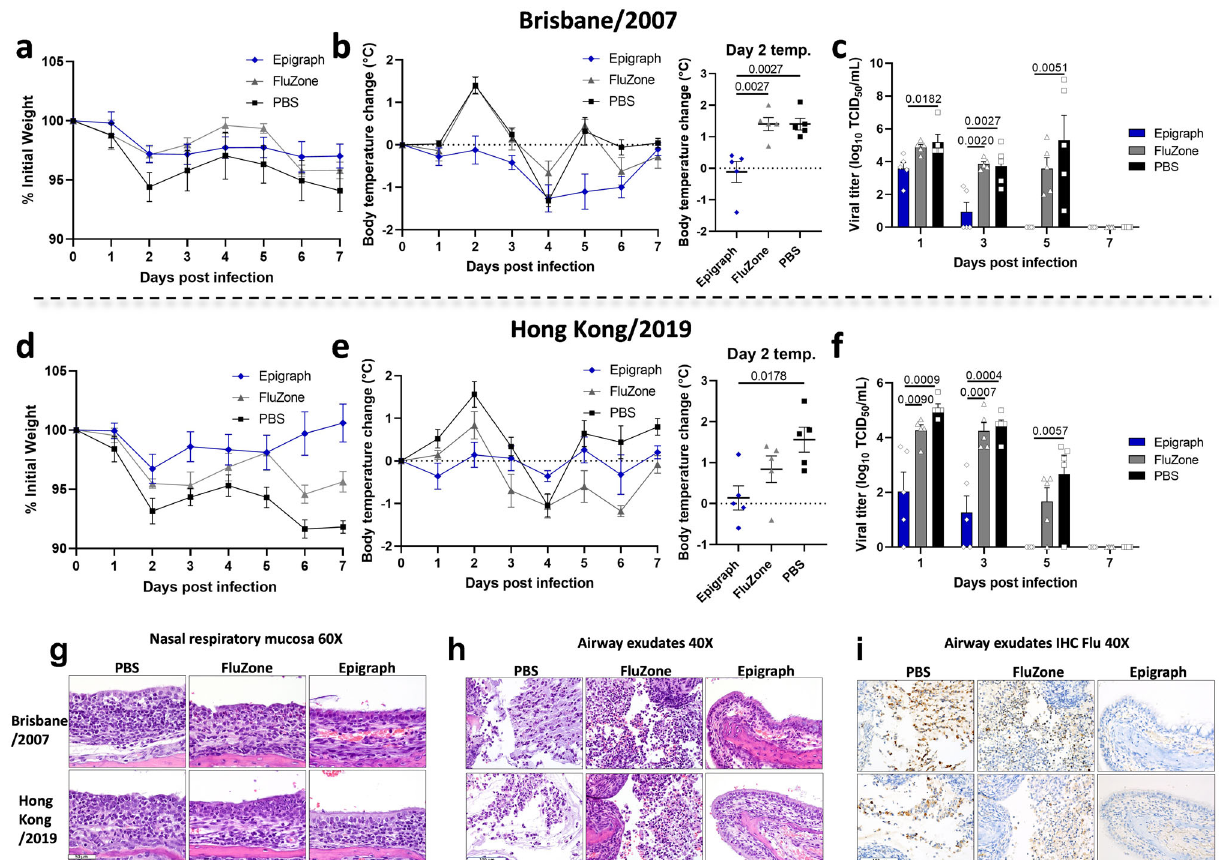
Fig. 8 Epigraph immunization protects ferrets against challenge with two contemporary H3 viruses. Ferrets were immunized twice with 5 × 10 10 vp of HAdV-5-Epigraph, the FluZone vaccine, or a mock PBS vaccine. Two weeks after boosting, ferrets ( n = 5) were challenged intranasally with 10 5 TCID 50 of contemporary strains Brisbane/2007 ( a – c ) or Hong Kong/2019 ( d – f ). Ferret ’ s weight ( a , d ) and body temperature ( b , e ) were monitored over 14 days (day 1 – 7 n = 5; day 8 – 14 n = 3). Peak body temperature at day 2 post infection ( n = 5; one-way ANOVA with Tukey multiple comparison). On day 1, 3, 5, 7, and 9 post infection, nasal washes were taken to evaluate viral titer kinetics by TCID 50 (day 1, 3, 4, 7 n = 5; day 9 n = 3; one-way ANOVA with Tukey multiple comparison). At day 7 post infection, two animals per group were sacri fi ced